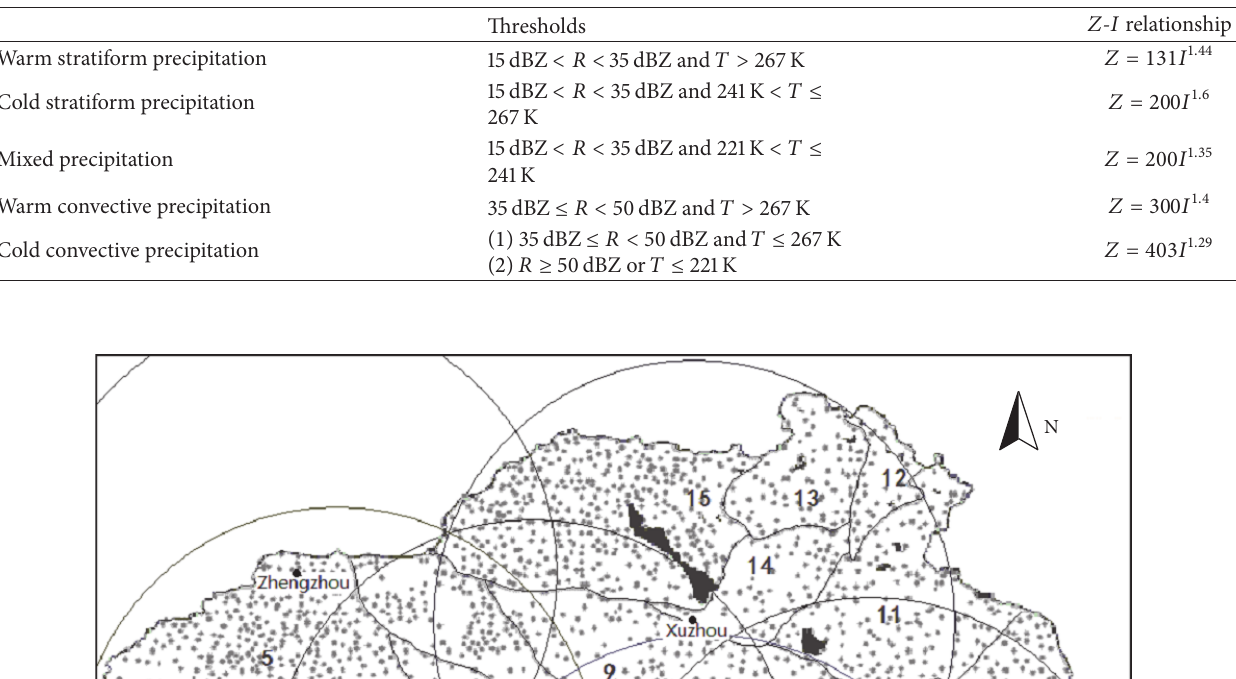
Table 1: Thresholds of cloud type Determined.